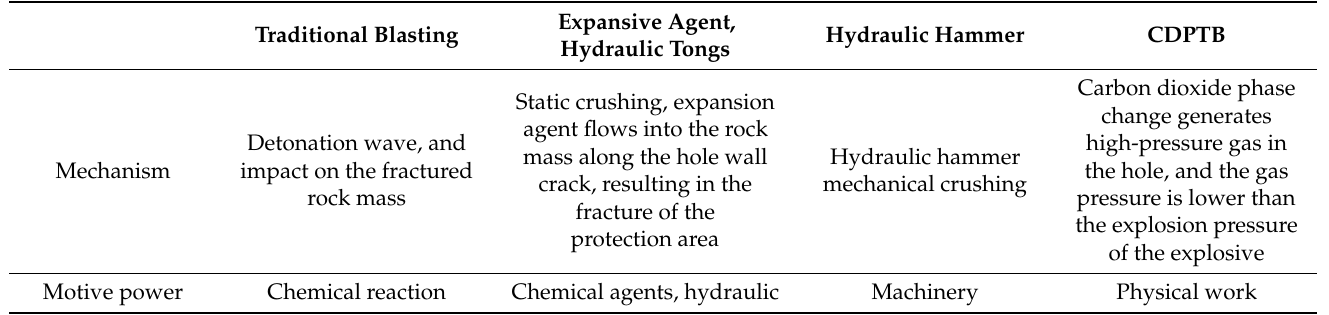
Figure 25. Drilling layout plan for engineering construction. ( a ) Step single-row one-line type of foundation pit slope; ( b ) Step plum-shaped foundation pit slope; ( c ) Parallel hole of subway tunnel; ( d ) Cutting hole of subway tunnel. Table 3. Comparison of different rock breaking methods.